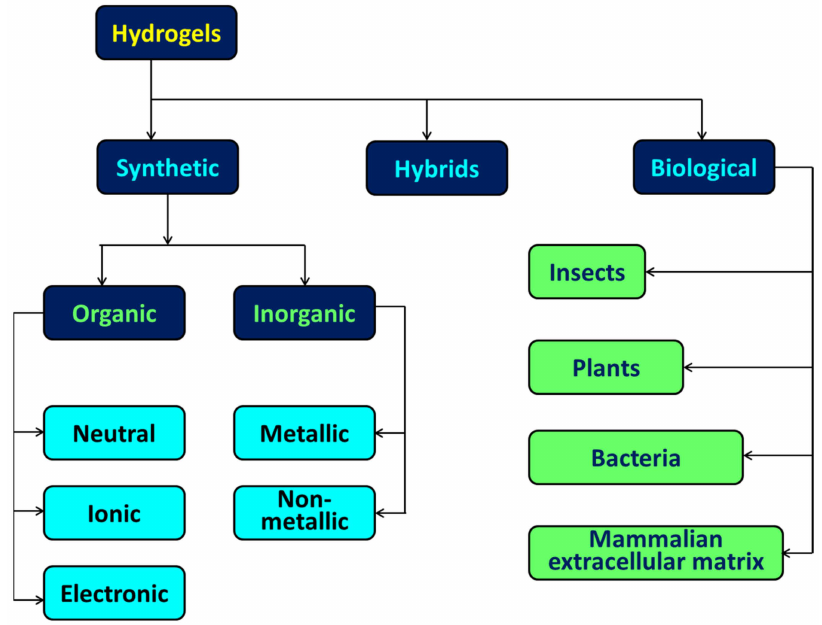
Figure 8. The categorization of hydrogels with respect to their constituents and their